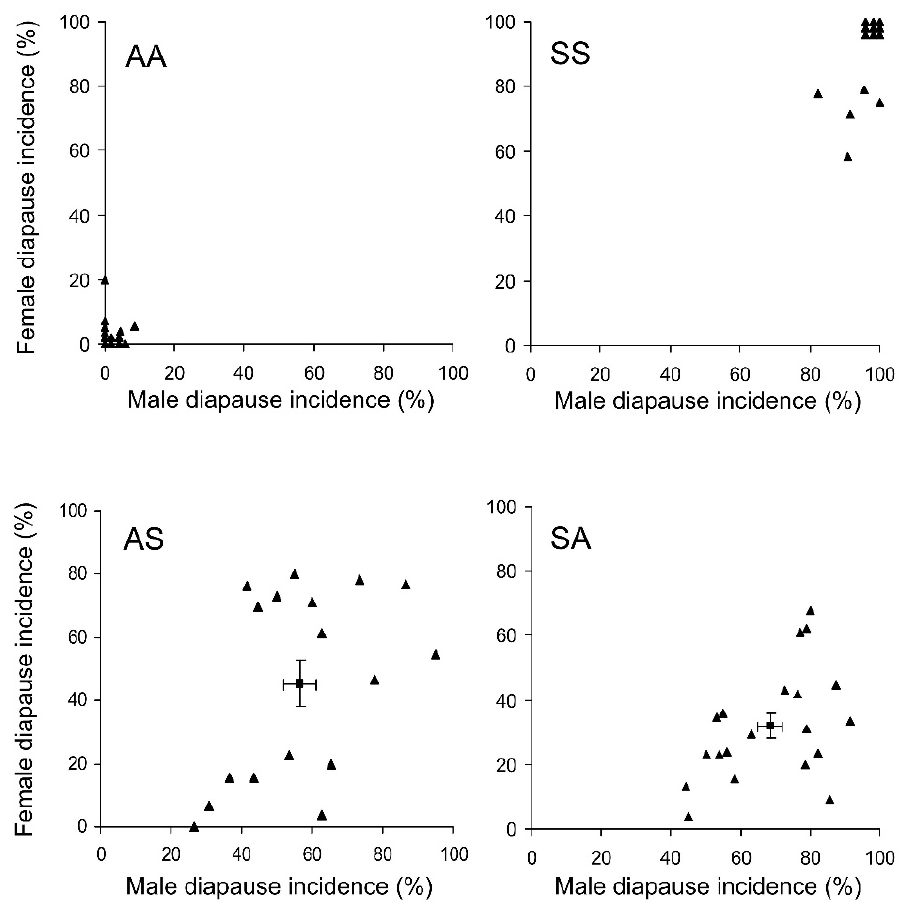
Figure 2. Diapause incidence in male and female progeny of different parental pairs of the four Halyomorpha halys cross types. The cross types are indicated by the initials of population origin of female and male: A—Andong, S—Sochi. Each symbol (triangle) corresponds to one parental pair; the percentages of diapause in male (X-axis) and female (Y-axis) progeny are presented. For the two hybrid crosses (AS and SA), mean and SEM are also presented (for pure crosses, means are not presented as they would overlap data points). Some symbols are slightly shifted to avoid overlap.